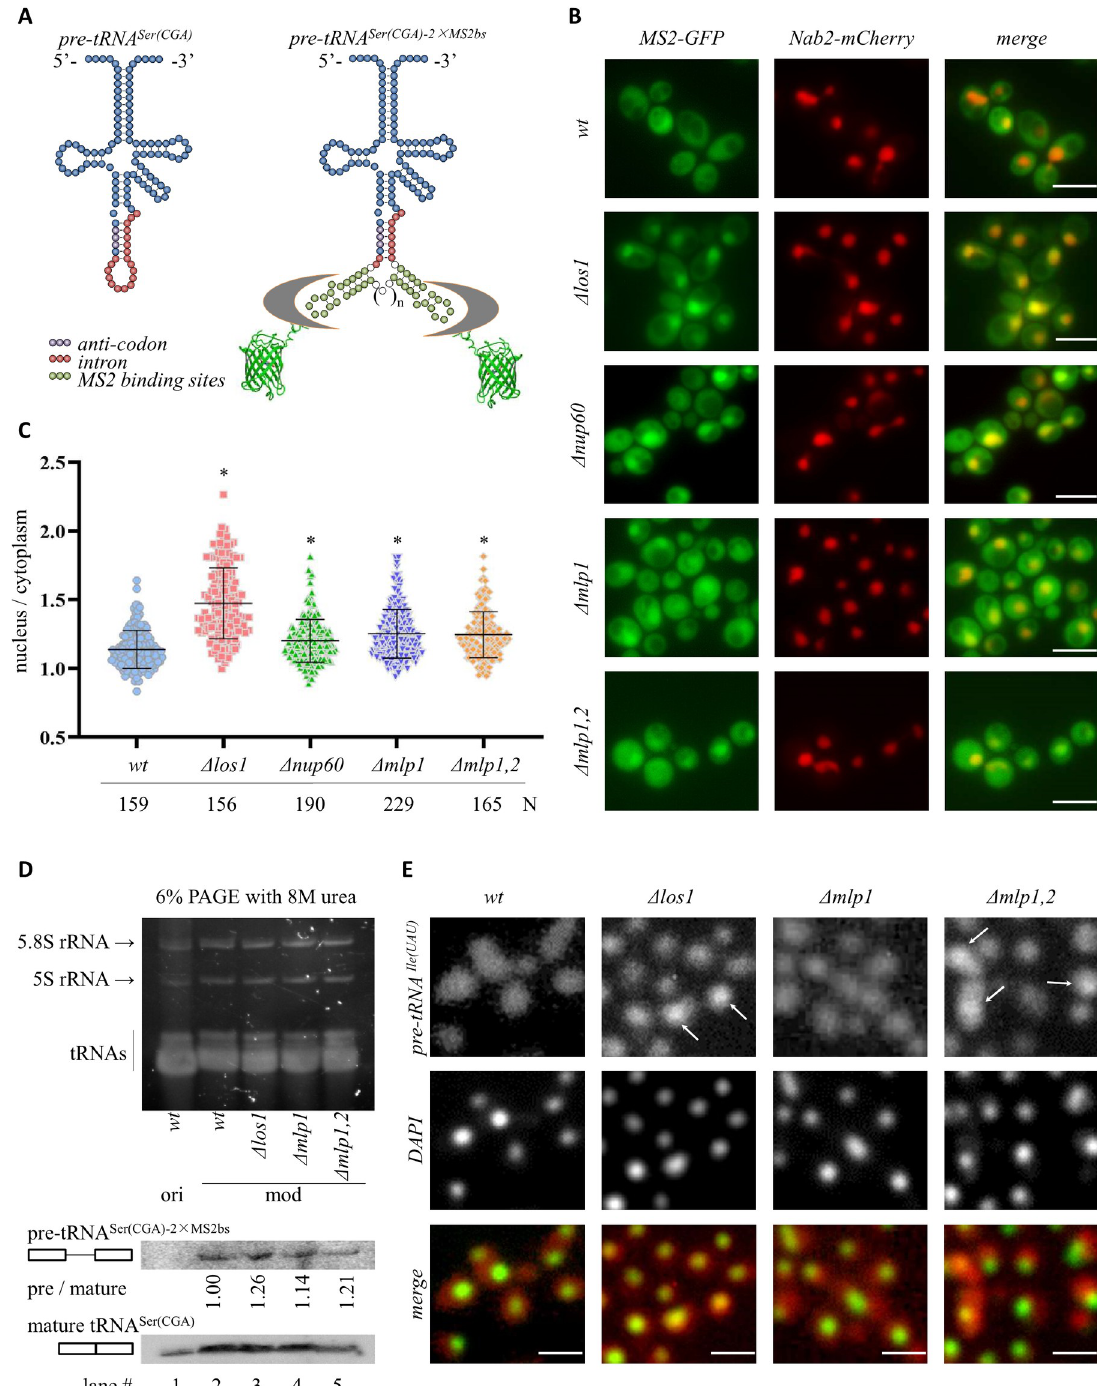
Fig 2. Mlp1/2 are required for tRNA export. (A) Schematics of unprocessed pre-tRNA Ser(CGA) with and without synthetic MS2 sites. Color code of nucleotides is shown. The MS2 sites are bound by an MS2-GFP chimera that is expressed in yeast. The intron containing MS2 sites is spliced from the tRNA when it reaches the mitochondrial surface in the cytoplasm. (B) Representative images of cells expressing pre-tRNA Ser(CGA) with MS2 sites, MS2-GFP, as well as Nab2-mCherry to image the nucleus. Asynchronously grown cultures of strains MRG5788 ( wt ), MRG5789 ( Δ los1 ), MRG5787 ( Δ nup60 ), MRG5816 ( Δ mlp1 ), and MRG5817 ( Δ mlp1 , 2 ) were used. Scale bar = 10 μ m. (C) Quantification was done by calculating the ratio of nuclear / cytoplasmic GFP signal intensity and shown in the column scatter graph. N denotes the number of cells examined, and � P < 0.05 by Student’s t -test when compared with the wt strain. (D)